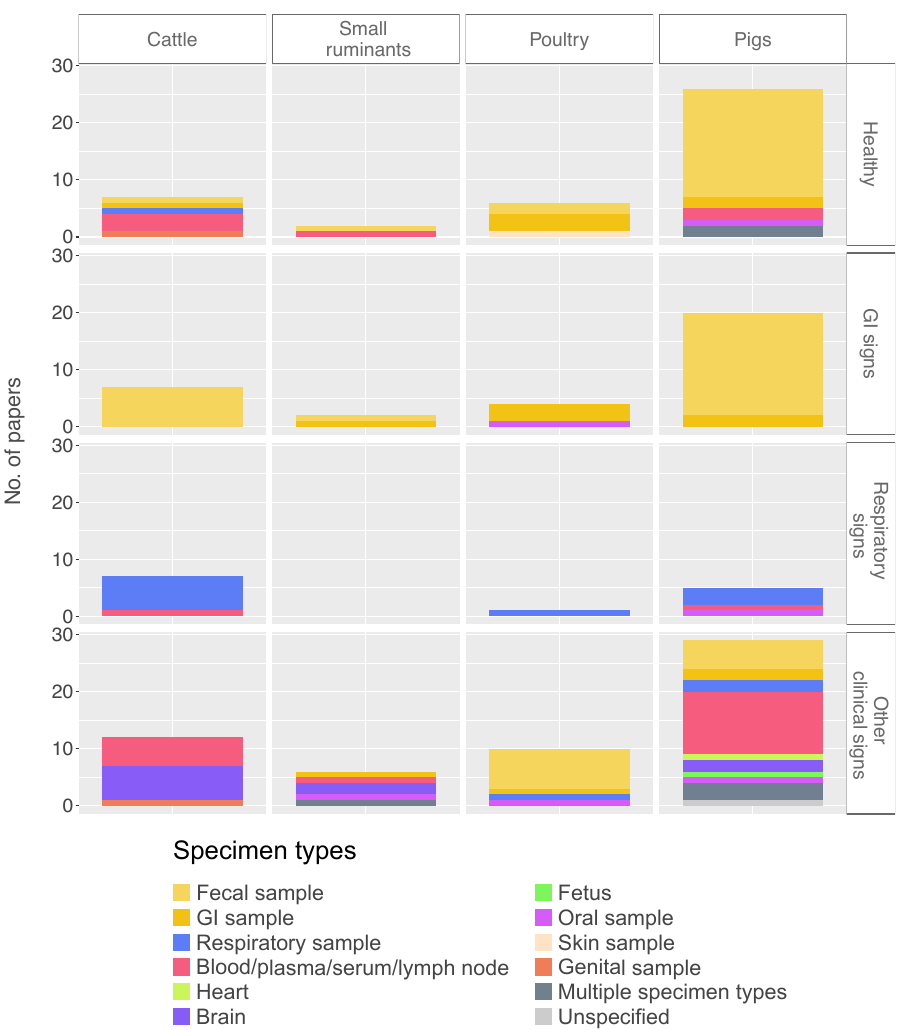
Figure 4. Types of specimens tested in di ff erent farm animals by number of papers, stratified by reported health conditions. Categories per variable are color-coded as shown in the legend. GI = gastrointestinal. A version of Y -axis as frequency (%) can be found in Supplementary Materials Figure